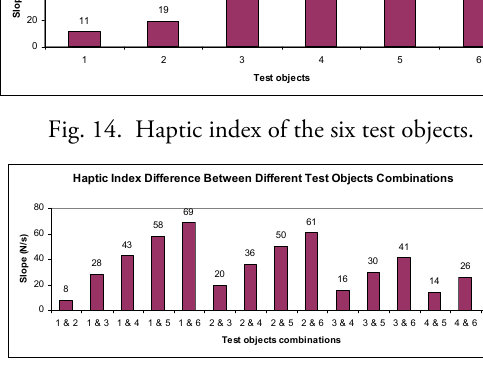
Fig. 15. Haptic index difference between different test object